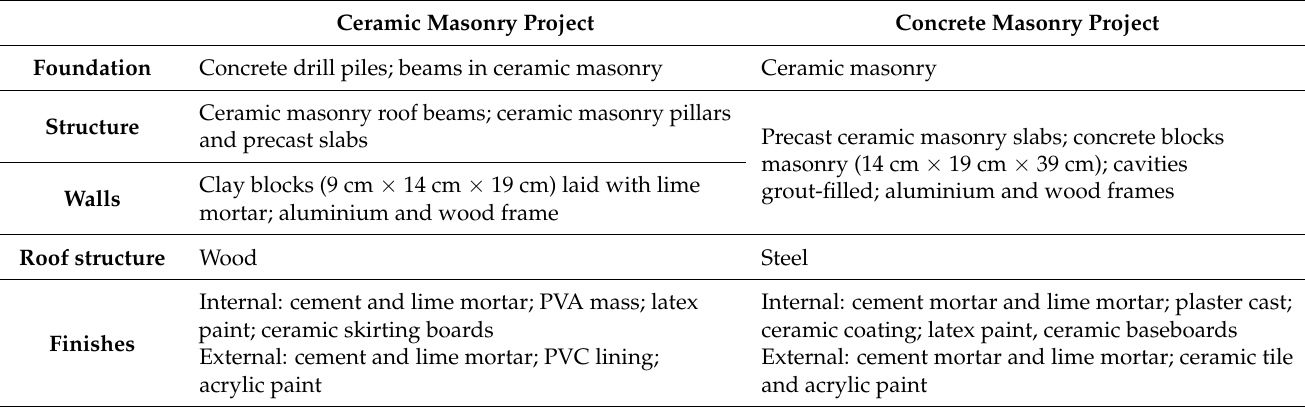
Table 1. Overall system of Brazilian Social Interest Housing